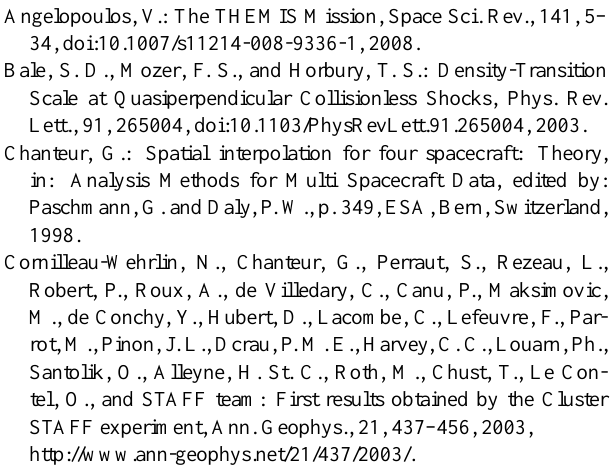
to higher reliabilities of the timing method. Here we perform the same simulation steps, again with the modeled discon- tinuity moving at 0.5 km/s in the − x-direction and the time delay standard deviation of 1 s, but select only those cases with all of the four residuals smaller than 1 s, to calculate the Fig. 4, which may be directly compared with the uncertain- ties shown in Fig.